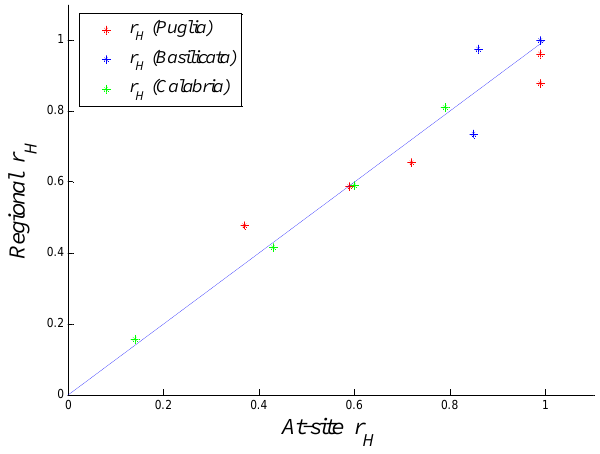
Fig. 6. Comparison between the at-site and regional estimates of r and r L for all river basins.